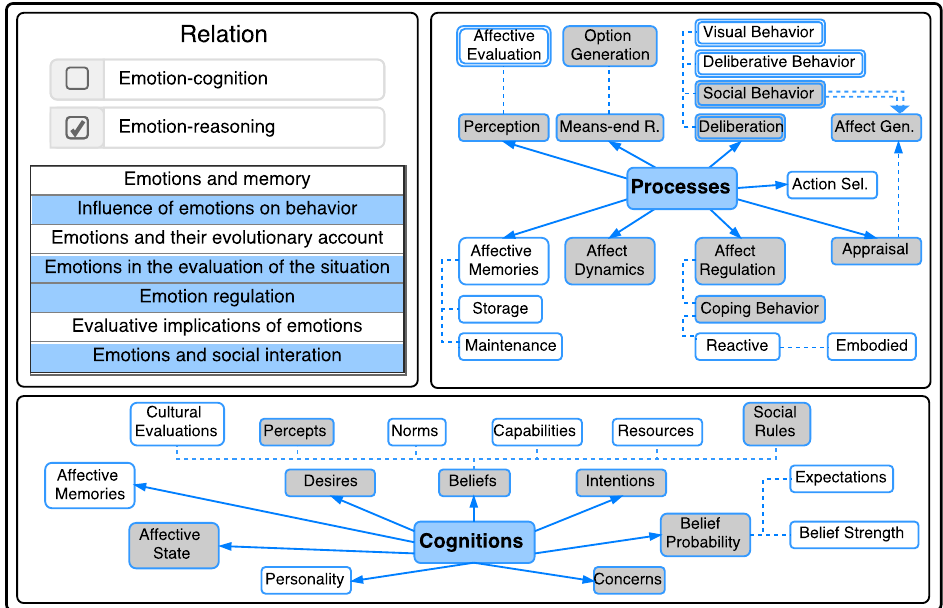
Figure 5. Processes and cognitions of the BayesAct